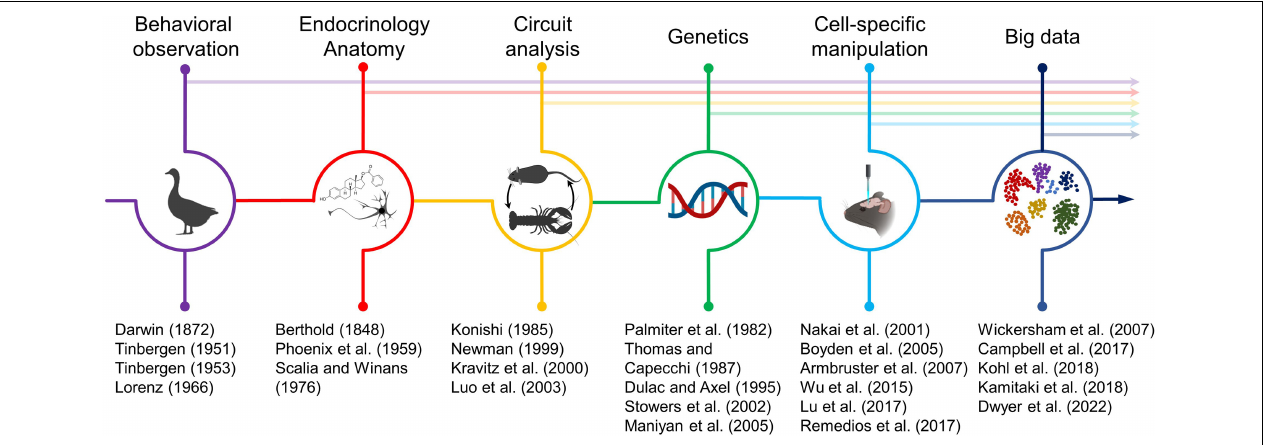
FIGURE 1 | Timeline of the dynamic relationship between technological innovation and biological insight in neuroscience. Technical trends that have profoundly shaped mechanistic insight for social neuroscience are highlighted at the top. Arrows indicate that most developed technologies continue to shape neuroscience to this day. Key papers describing either the development of a technical innovation or the adaptation of a new technique for investigating brain function are listed at the bottom. Select icons adapted from BioRender.com.